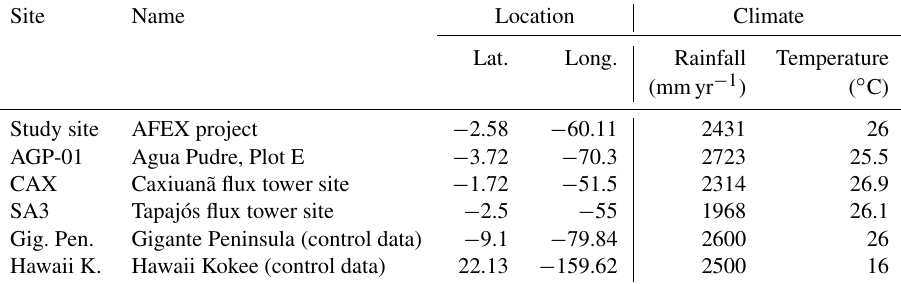
Table 3. Test site name, location, and climate characteristics. Site Name